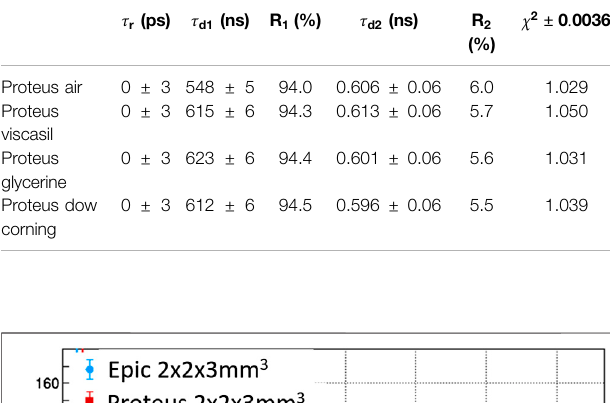
TABLE 4 | Parameters of the double exponential fi t, convolved with the IRF, used to describe the data from the TCSPC measurements with a 2 × 2 × 3mm 3 BaF 2 pixel from Proteus, using various optical coupling media and fi lters in front of the hybrid PMT. Here τ r is the rise-time, τ dn the decay times, and R n ( n (cid:3) 1, 2, 3) their corresponding abundances.